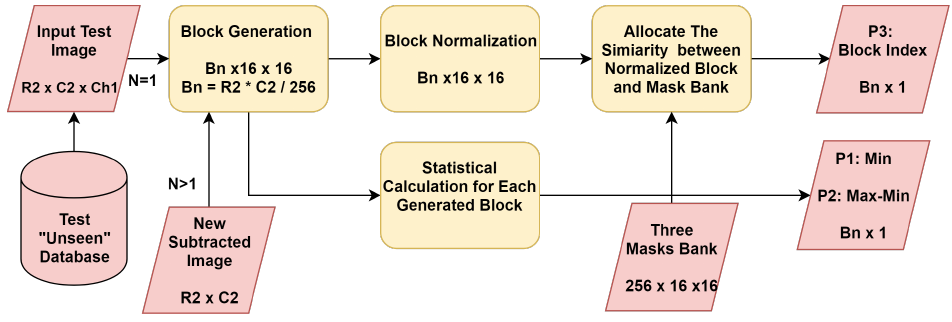
Figure 6. The parameter generation